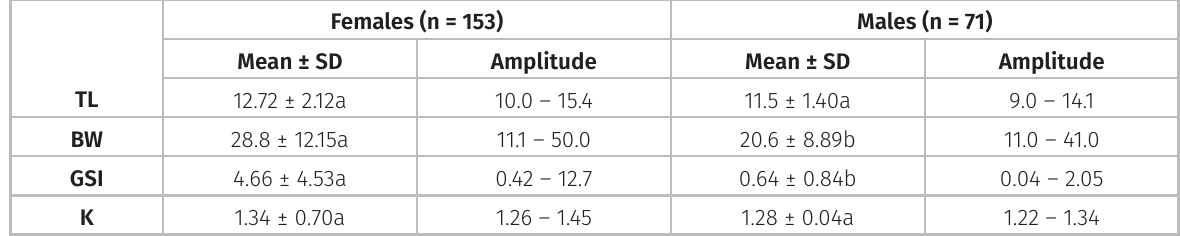
Table II. The amplitude, mean, and standard deviation (SD) of the total length (TL) in centimeters, body weight (BW) in grams, gonadosomatic index (GSI), and Fulton condition factor (K) of S. elegans females and males